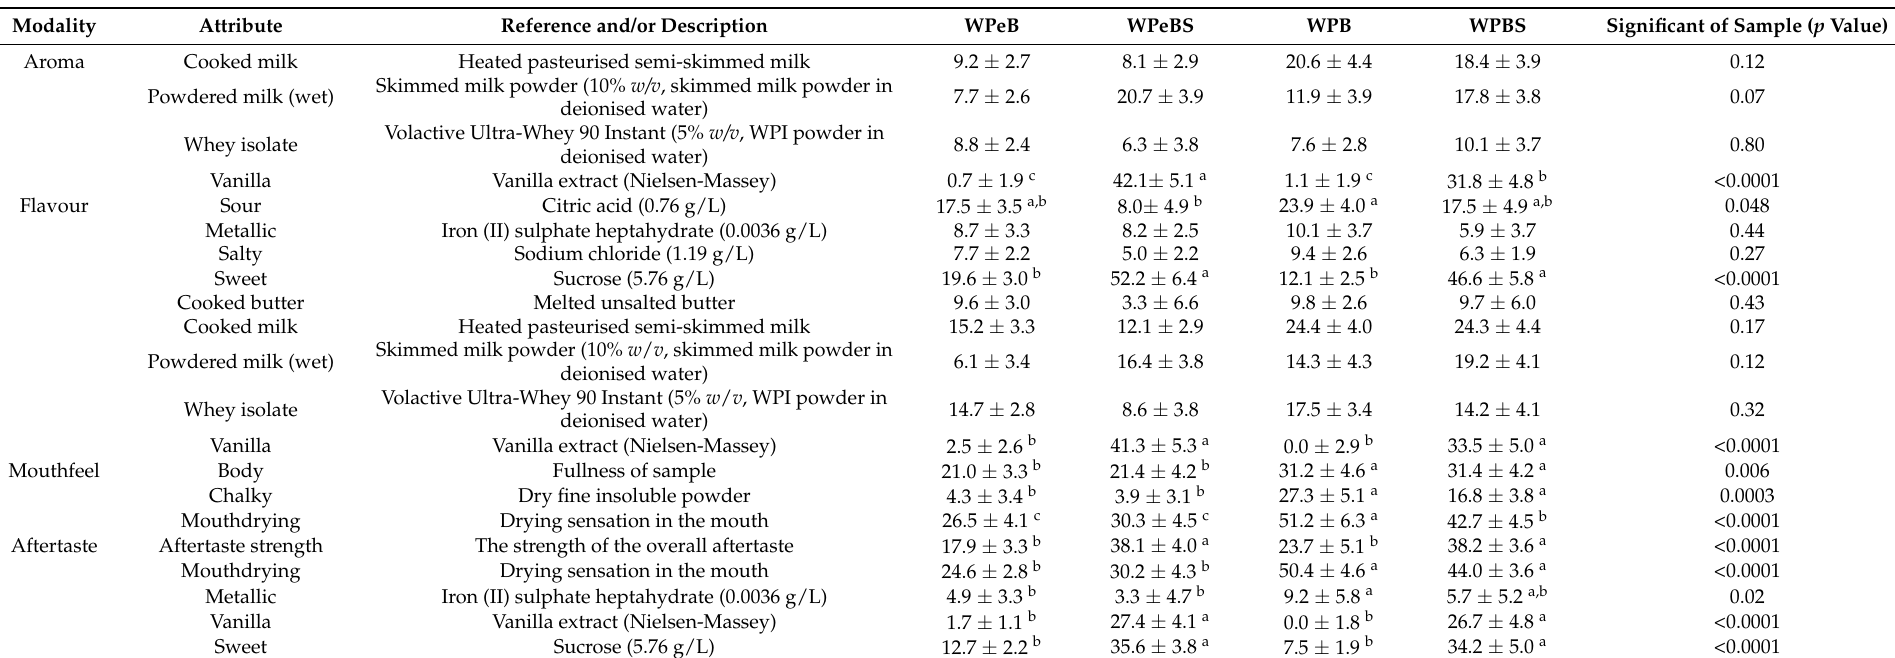
Table 3. Sensory profile (means of two replicates ± standard error) of whey beverages (WPeB: whey permeate beverage; WPeBS: whey permeate beverage sweetened; WPB: whey protein beverage; WPBS: whey protein beverage